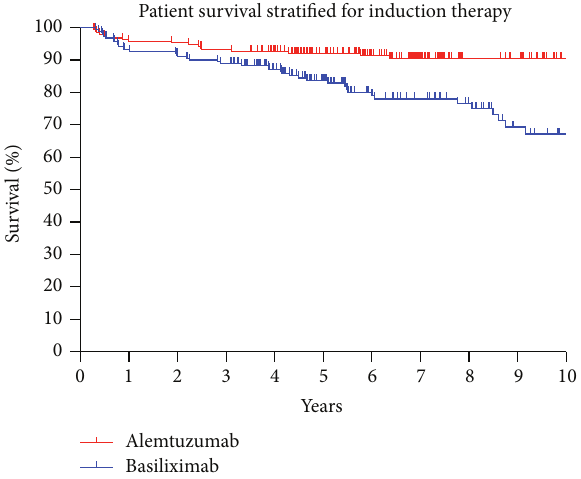
Figure 2: Patient survival after 1, 5, and 10 years was 95.85%, 92.16%, and 90.43% in the alemtuzumab group versus 92.67%, 83.77%, and 62.25% for KTx recipients who received basiliximab; 𝑝 = 0.001 .